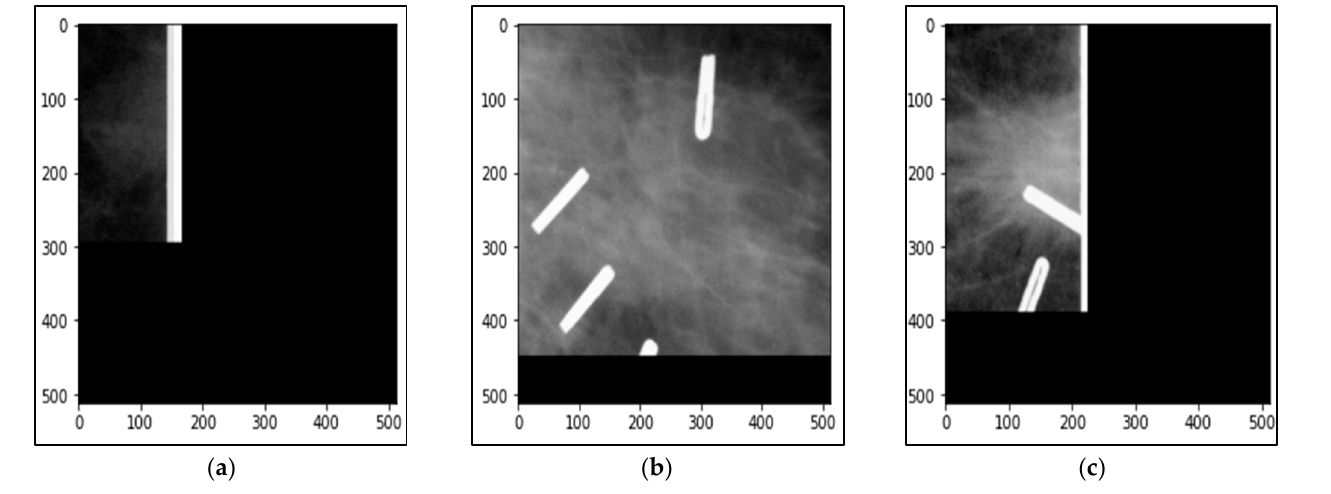
Figure 4. Some samples of the patches that were removed from the generated datasets. ( a ) a patch image with bad resolution, ( b , c ) are patches with white shapes that mislead the correct classification.